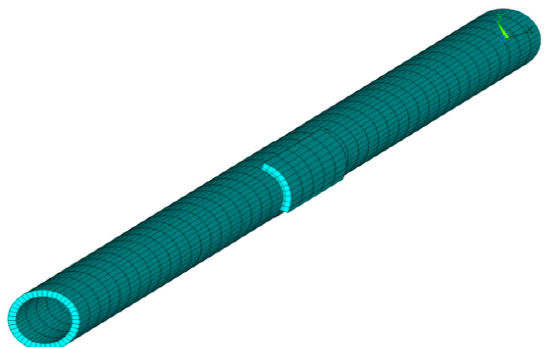
Figure 5. Finite element model of active constrained layer damping pipeline.